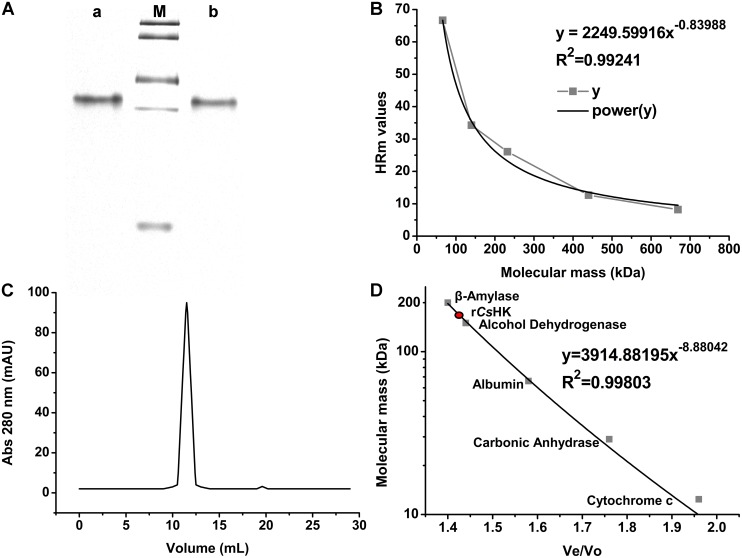
Determination of the Mr of rCsHK.(A). M, the protein bands with known molecular mass (HMW Native, GE Healthcare, USA) were stained with Coomassie blue in descending order: thyroglobulin (669 kDa), ferritin (440 kDa), catalase (232 kDa), lactate dehydrogenase (140 kDa), and bovine serum albumin (67 kDa). a, Fresh purified rCsHK. b, rCsHK stored for 4 weeks at −80°C with four cycles of freezing and thawing. (B). The Mr of rCsHK as determined by 8% native PAGE. The HRm values of the molecular markers were plotted against their Mr. The equation and curve were drawn. The Mr of rCsHK was calculated using the obtained equation. (C). Elution profile of rCsHK in gel filtration chromatography. (D). Mr of rCsHK as determined by the elution profile. The calibration curve between the elution volume (Ve) and the log molecular mass (kDa) of standard marker proteins was obtained by AKTA FPLC using a sepharose 12 10/300 GL gel filtration column. The Ve of rCsHK was obtained, and the Mr of rCsHK was calculated using the deduced equation.